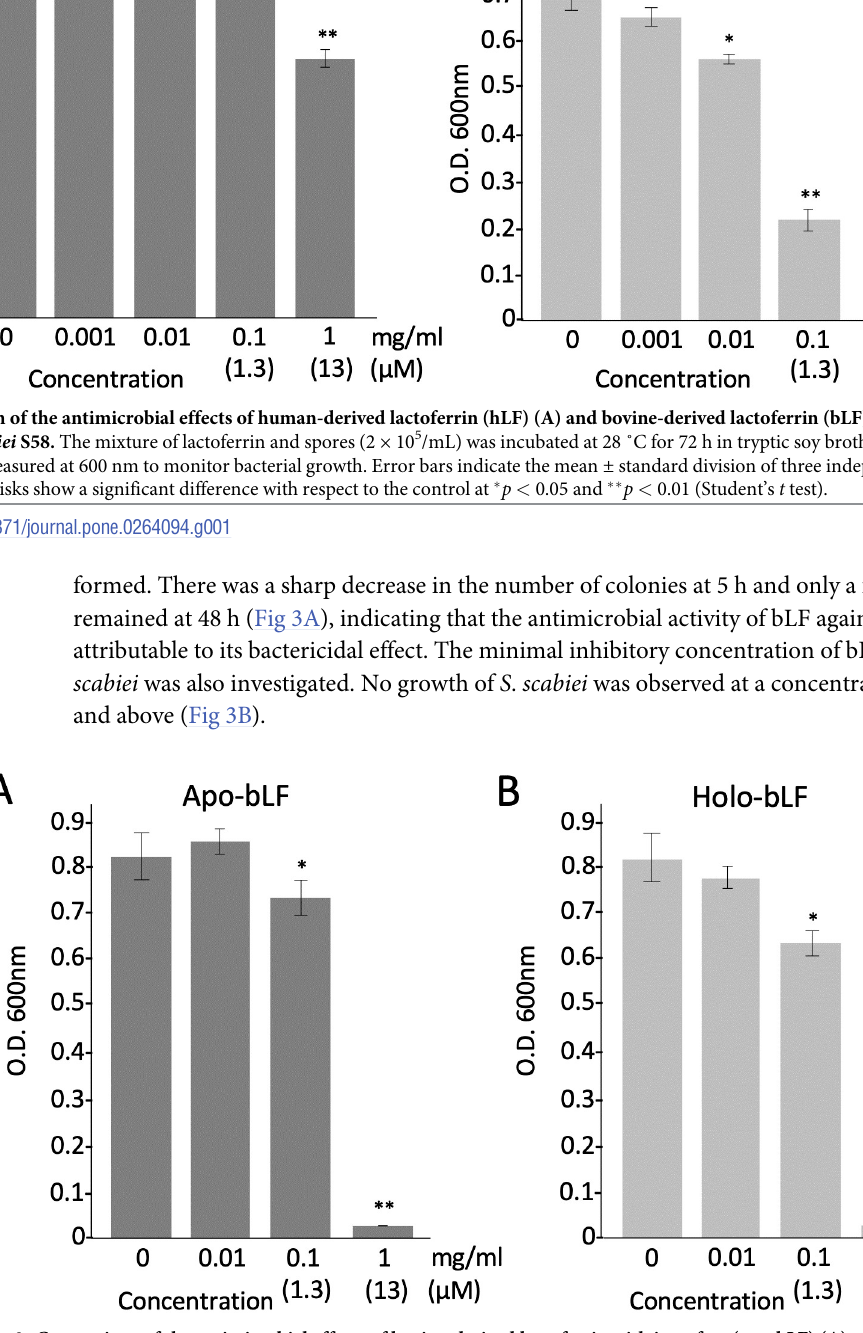
Fig 2. Comparison of the antimicrobial effects of bovine-derived lactoferrin with iron-free (apo-bLF) (A) and bovine-derived lactoferrin saturated with iron (holo-bLF) (B) on Streptomyces scabiei S58. The mixture of lactoferrin and spores (2 × 10 5 /mL) was incubated at 28 ˚C for 72 h in tryptic soy broth and the absorbance was measured at 600 nm to monitor bacterial growth. Error bars indicate the mean ± standard division of three independent experiments. Asterisks show a significant difference with respect to the control at � p < 0.05 and �� p < 0.01 (Student’s t